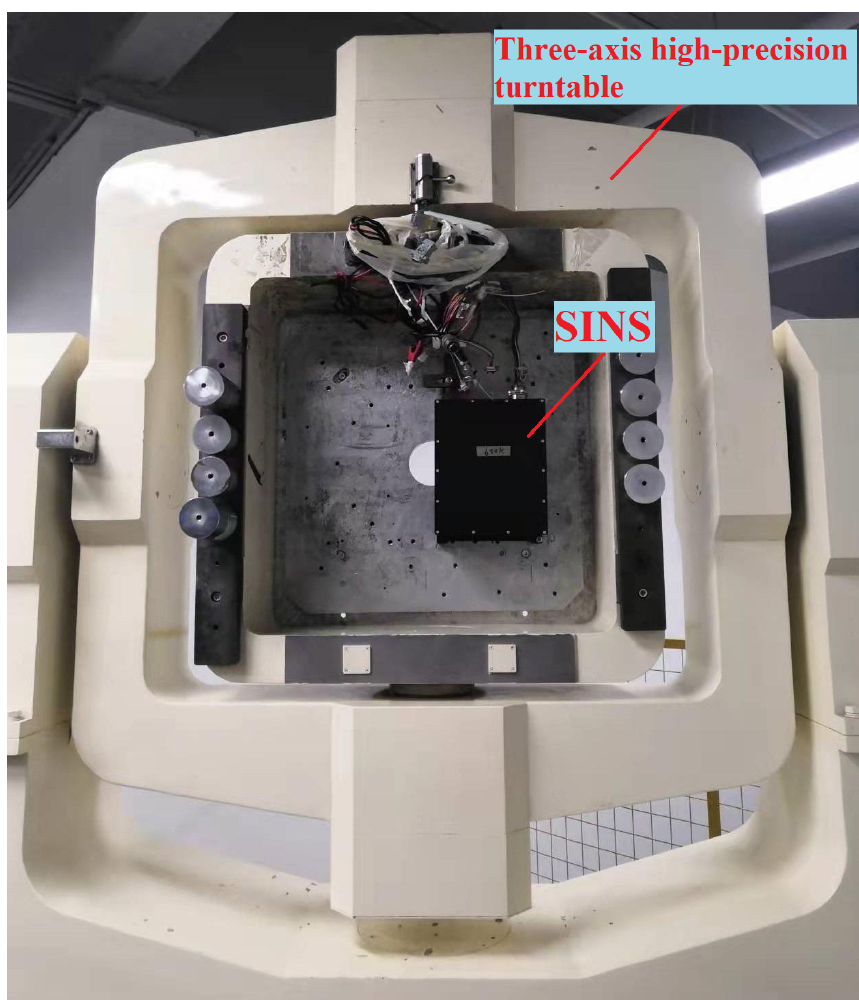
Figure 6. The diagram of the experimental system.